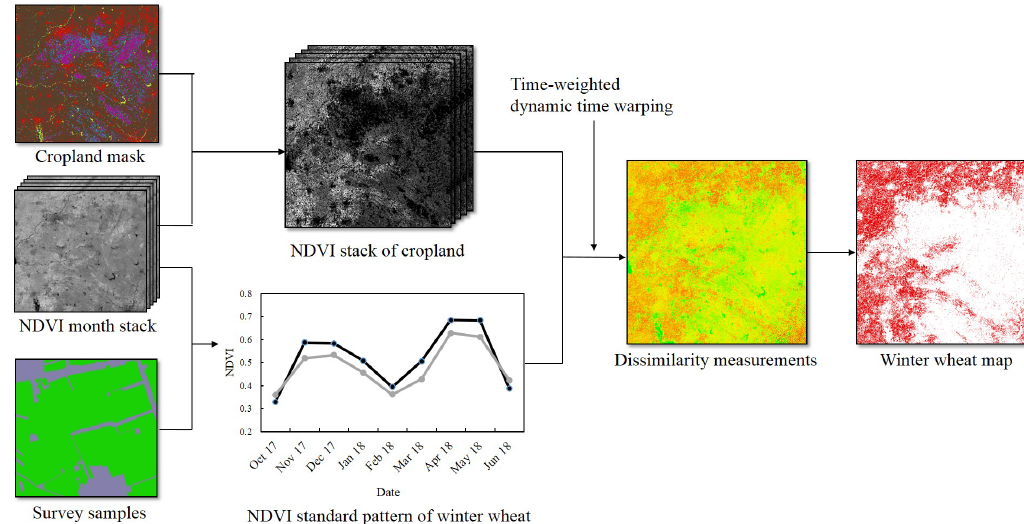
Figure 2. Flowchart of the proposed methodology for winter wheat classification.